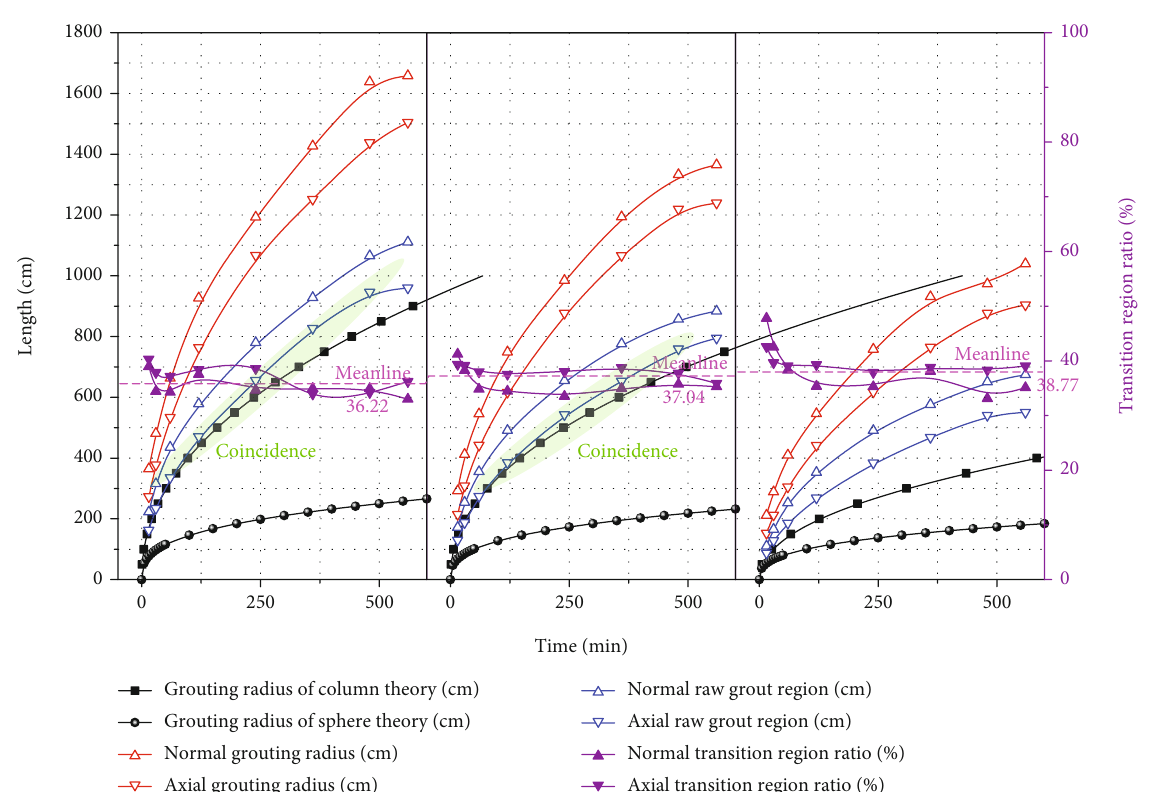
Figure 6: Comparisons between numerical simulation and theoretical calculation of grouting radius under di ff erent grouting pressures: (a) 2MPa; (b) 1.5MPa; (c)